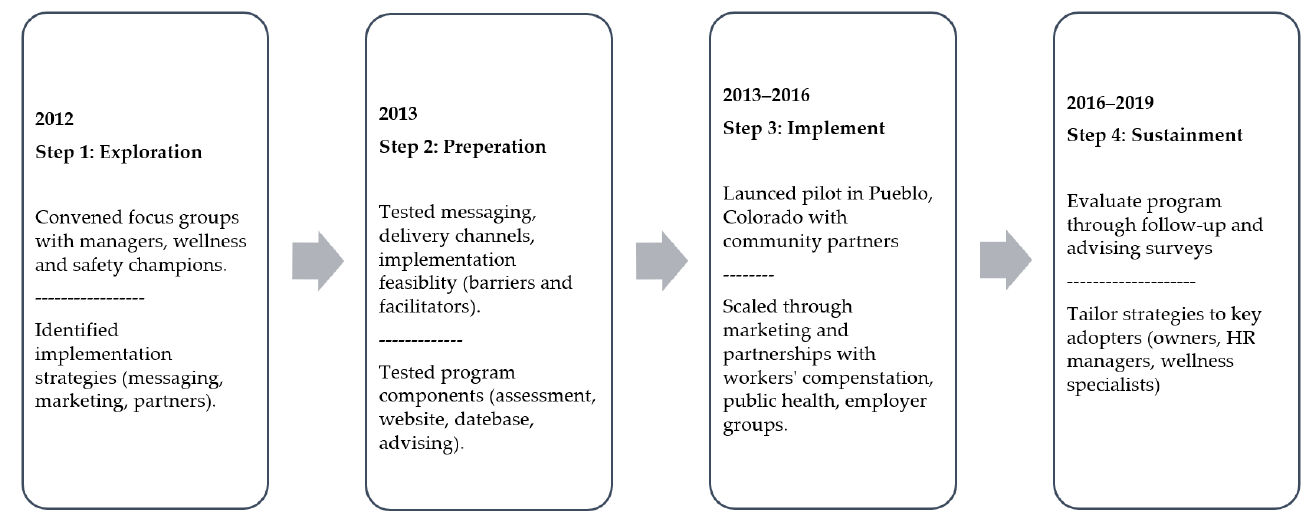
Figure 1. Timeline of Health Links implementation steps.